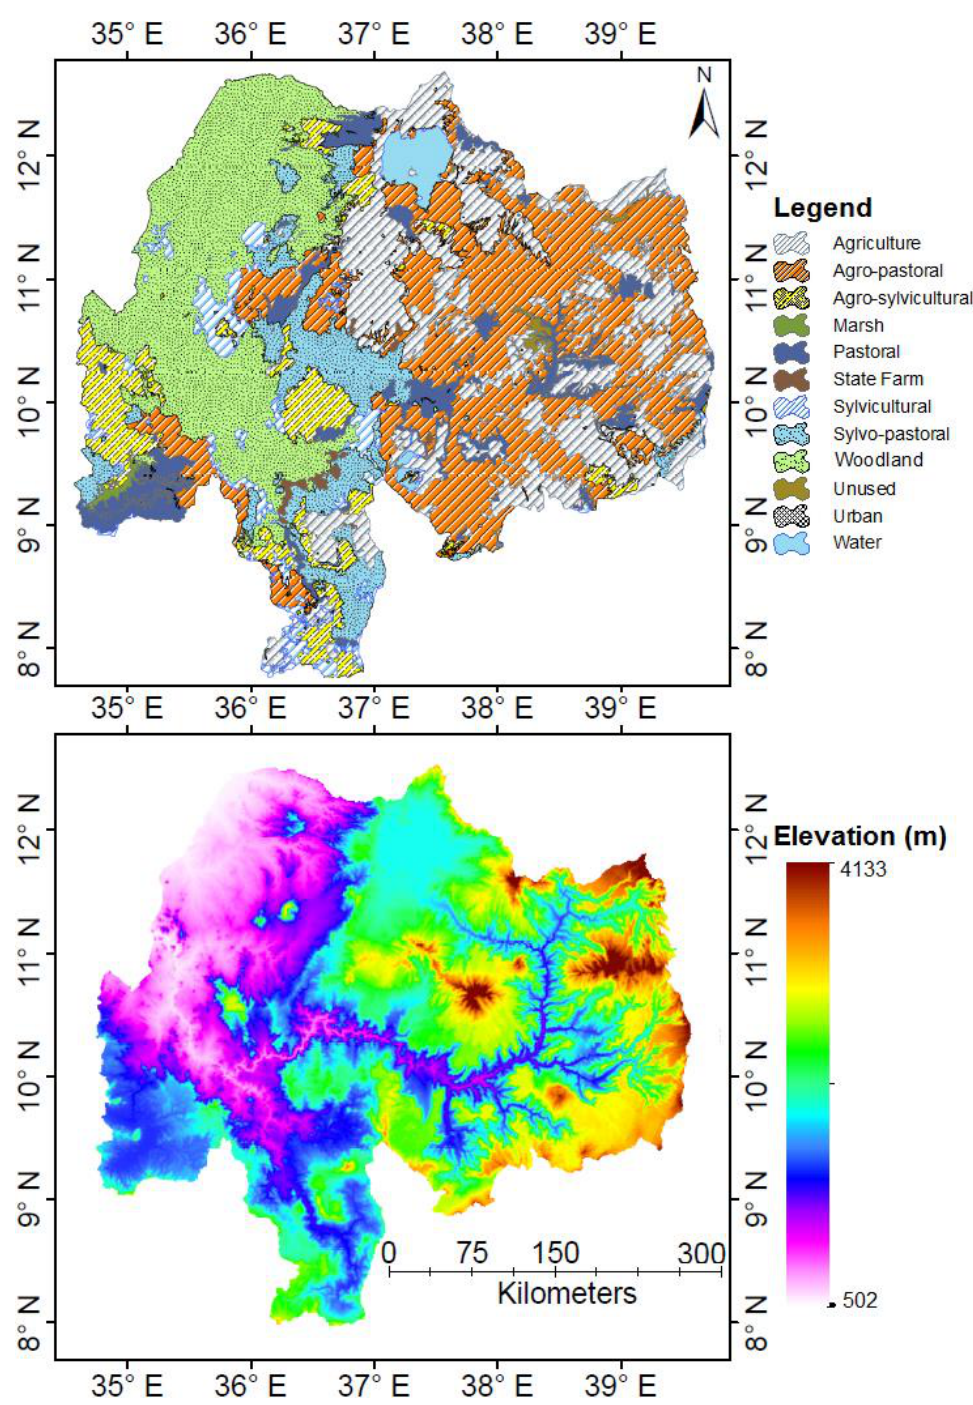
Figure 2. Land use (top) and topography (bottom) maps of the study